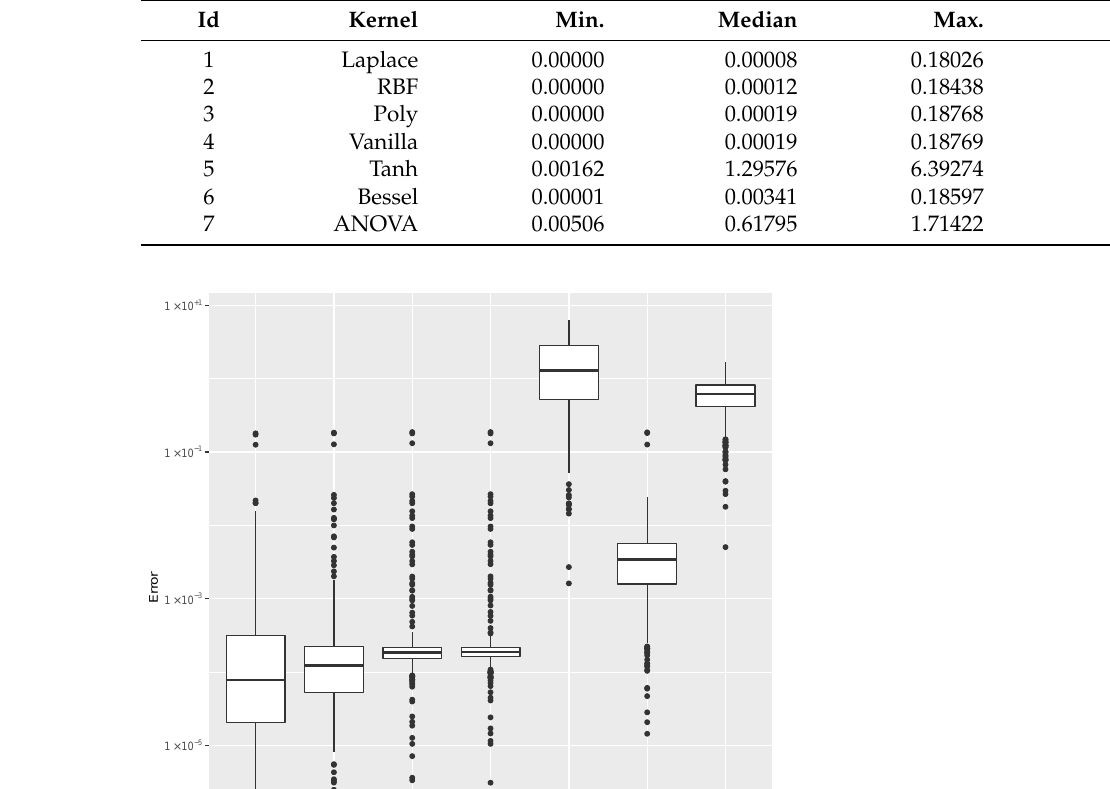
Table 1. Error statistics of the b I meta-model using distinct SVM kernel options.